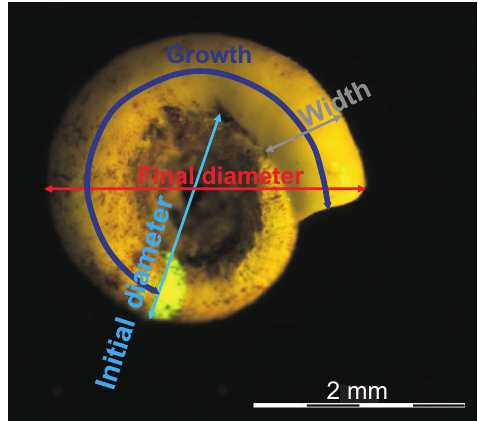
Figure 2. Fluorescence microscope view of S. spirorbis shell with indicators for measured size parameters used in this study (initial diameter, final diameter, growth length, tube width). Brightly fluo- rescent yellowish calcein stain line (lower left) marks beginning of shell part grown during